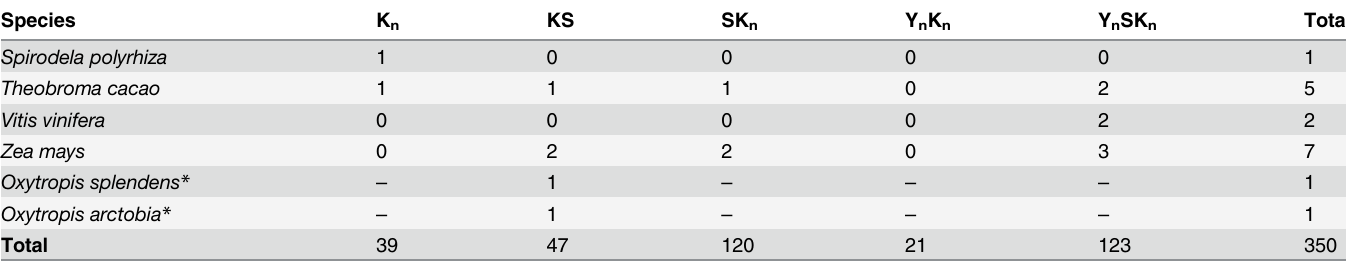
(Table 2): IBOXCORENT (I-box core) [94], REBETALGLHCB21 [95] and SREATMSD [96], respectively. These three experimentally validated motifs share four nucleotides